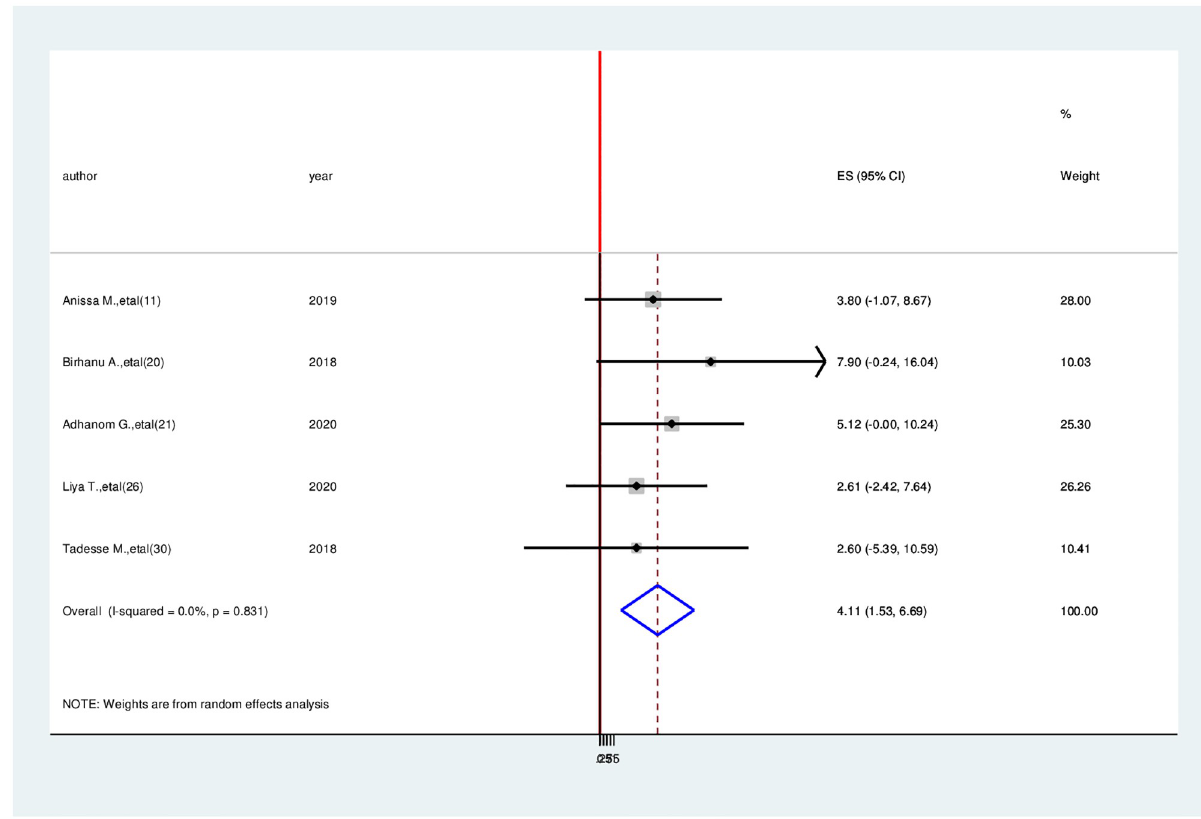
Fig 7. Association between having physical functioning and health-related quality of life among cancer patients in